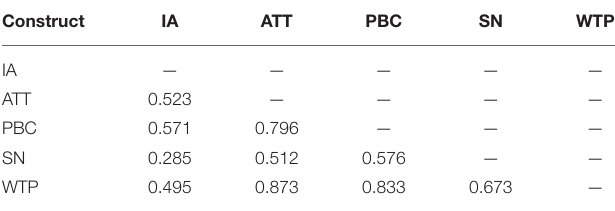
TABLE 5 | Heterotrait-monotrait ratio. Construct